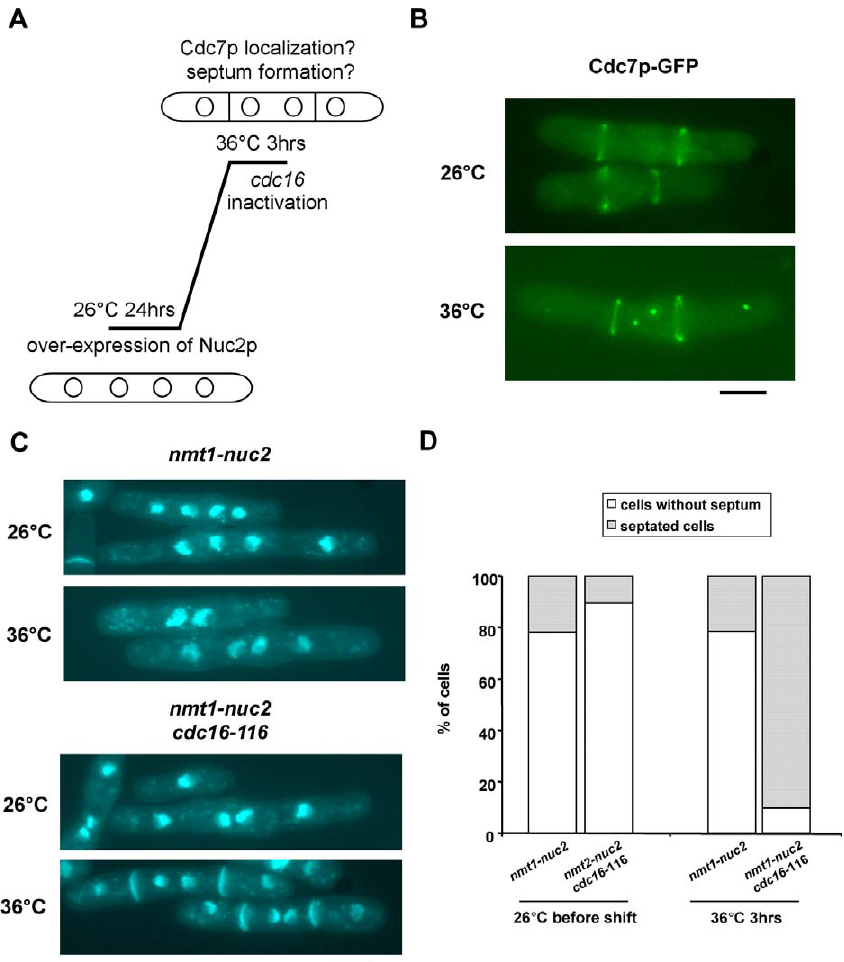
Figure 6. Inactivation of Cdc16p Function Promotes Localization of Cdc7p to SPBs and Allows Septation in Cells Overexpressing Nuc2p (A) Diagram schematically illustrates the experimental design. Nuc2p was induced for 24 h at 26 8 C, and the culture was shifted to 36 8 C to inactivate Cdc16p and examined after 3 h of incubation. (B) The localization of Cdc7p-GFP in cdc16 -116 cells overexpressing Nuc2p was visualized by fluorescence microscopy at the permissive or restrictive temperatures. (C) Septum assembly is restored upon inactivation of Cdc16p in cells overexpressing Nuc2p. DAPI and aniline blue staining of formaldehyde fixed cells is shown. (D) Quantification of septated cells versus non-septated cells in nmt1-nuc2 and nmt1-nuc2 cdc16- 116. Note that only cells with four nuclei were counted. Scale bar, 5 l